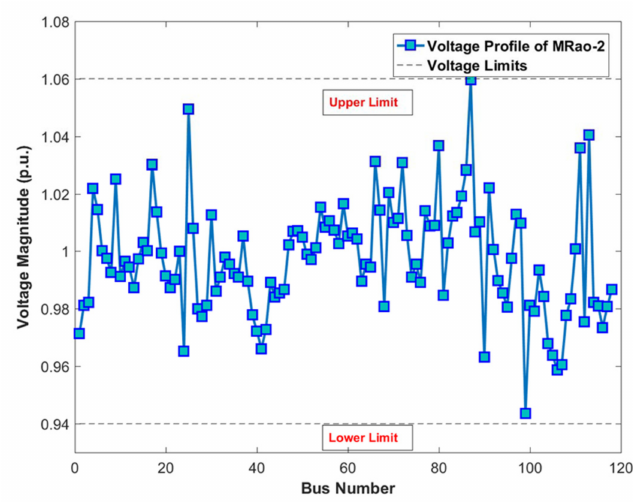
Figure 15. The voltage profile of the MRao-2 for case